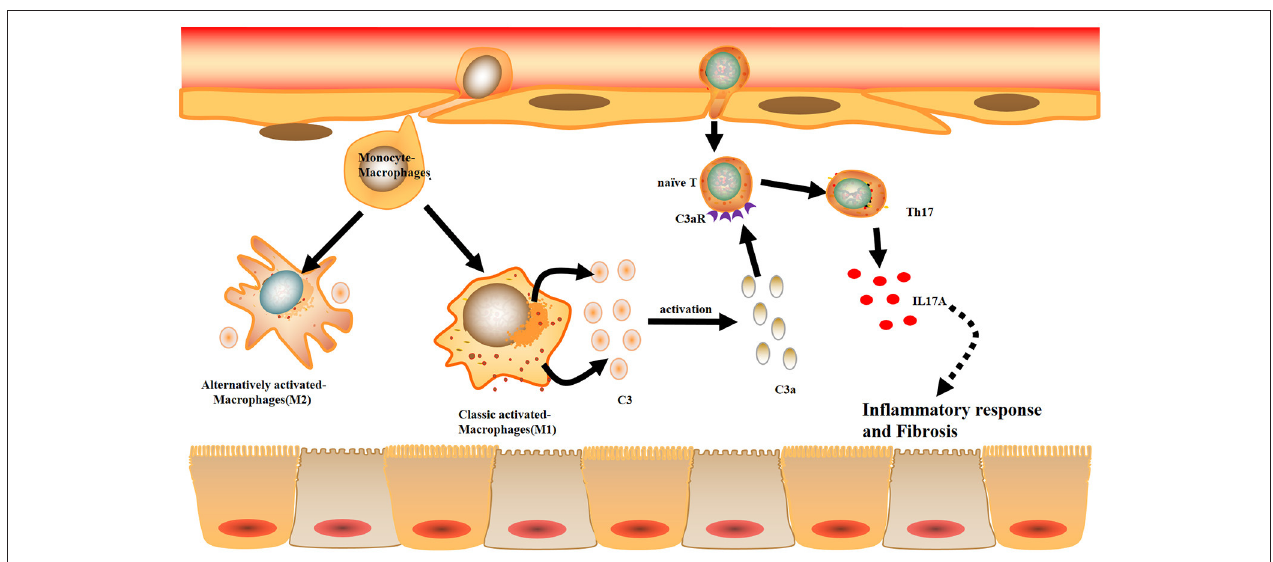
FIGURE 10 | Model summarizing the role of local C3 in the development of renal fibrosis. Local C3 secretion by macrophages may be contributed to the pathogenesis of renal TILs, involving the production of IL-17A and activation of ERK and STAT3 signaling